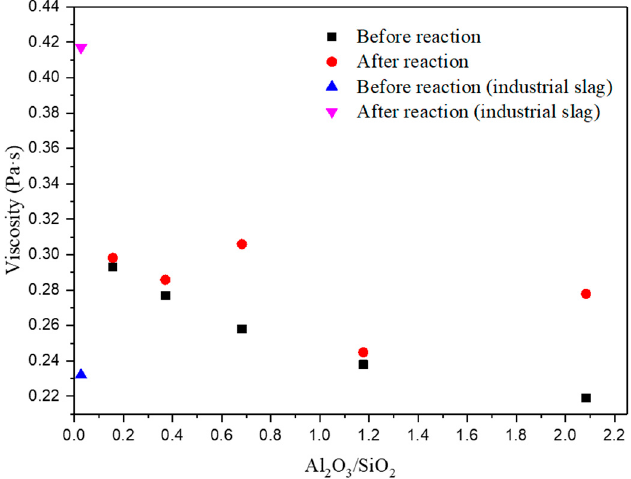
Figure 5. Comparison of the viscosity of the samples between before and after reaction.